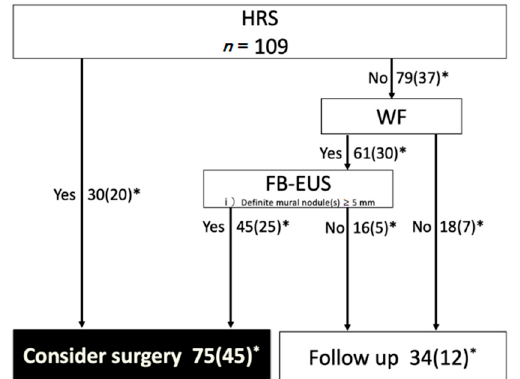
Figure 5. Algorithm for the management of BD-type IPMN as per the 2017 ICG. The recommended test for patients with WF on the diagnosis of malignancy is fundamental B-mode EUS. *, the number in parentheses is the number of malignant IPMNs; EUS, endoscopic ultrasound; WF, worrisome features; ICG, international consensus guidelines.